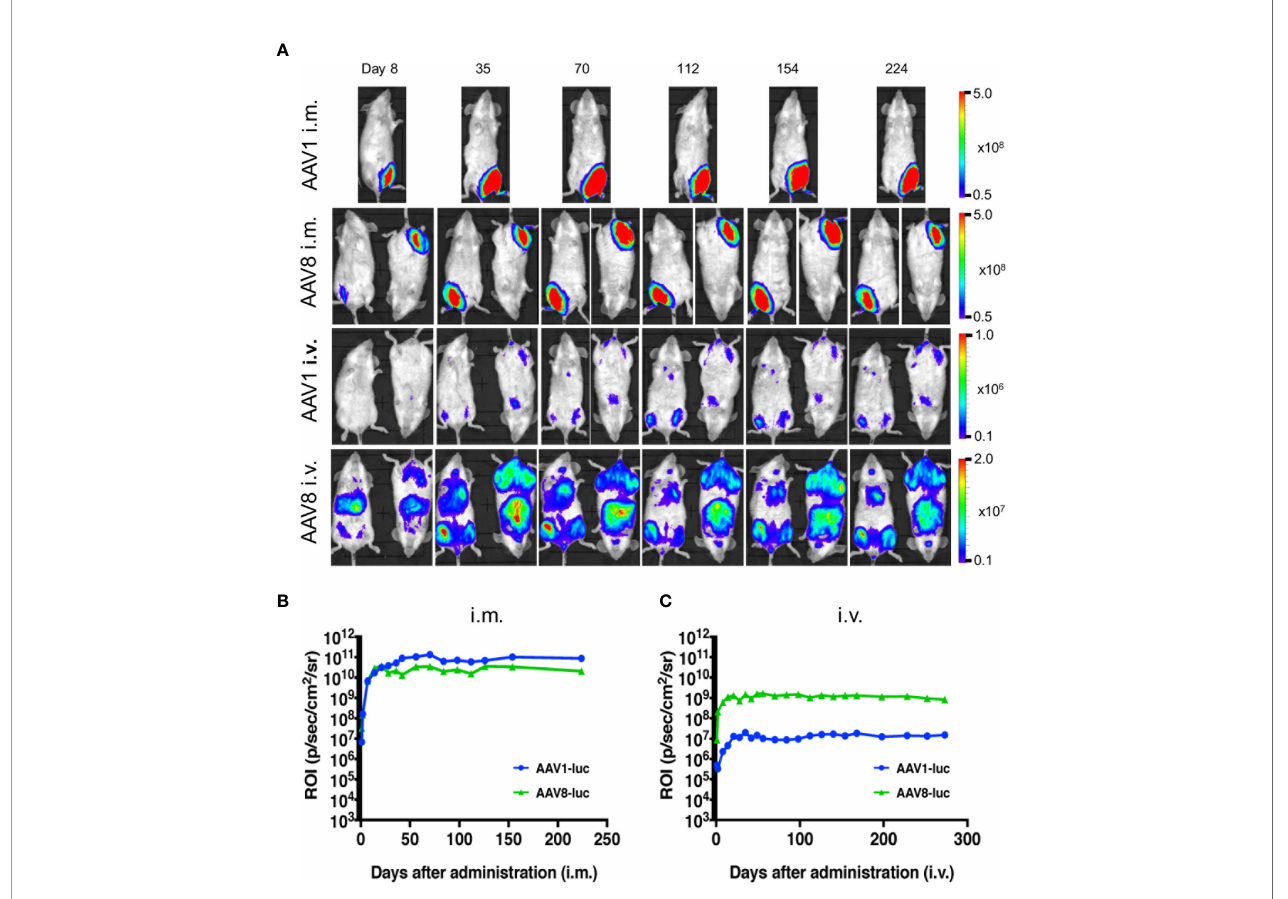
FIGURE 1 | Comparison of long-term transgene expression between AAV1-Luc and AAV8-Luc. (A) AAV1-Luc or AAV8-Luc was injected into the right medial thigh muscles or tail veins of mice (n = 2; 1.0 × 10 11 vg/mouse) on day 0. Luciferase expression at different time points was detected using the IVIS Lumina LT Series III in vivo imaging system. The heatmap images visible in the mice represent the total fl ux of photons (p/s/cm 2 ) in the area of interest. Rainbow scale ranges are expressed in radiance (p/s/cm 2 /sr. (B, C) The mean total fl ux of photons is shown as the region of interest (ROI) from day 0 to day 224 after i.m. (B) or i.v. administration (C) AAV-Luc